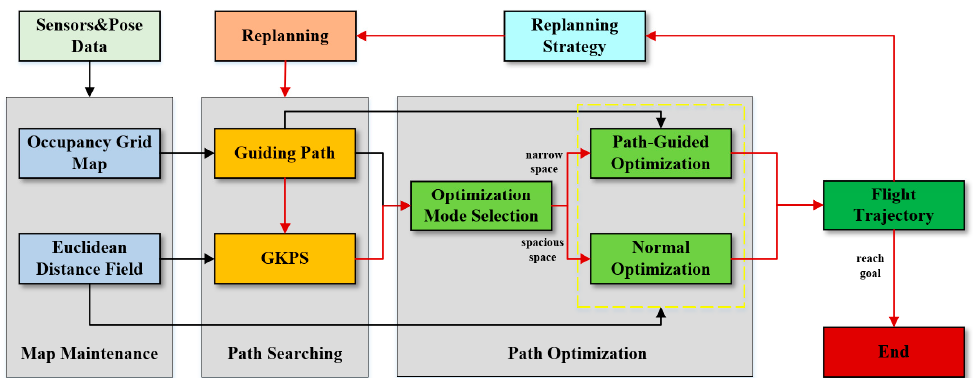
Figure 1. An overview of the proposed real-time replanning method for fast autonomous flight based on geometric path guiding. The red arrow represents the execution procedures of the method, and the black arrow represents that one part provides information for another part.